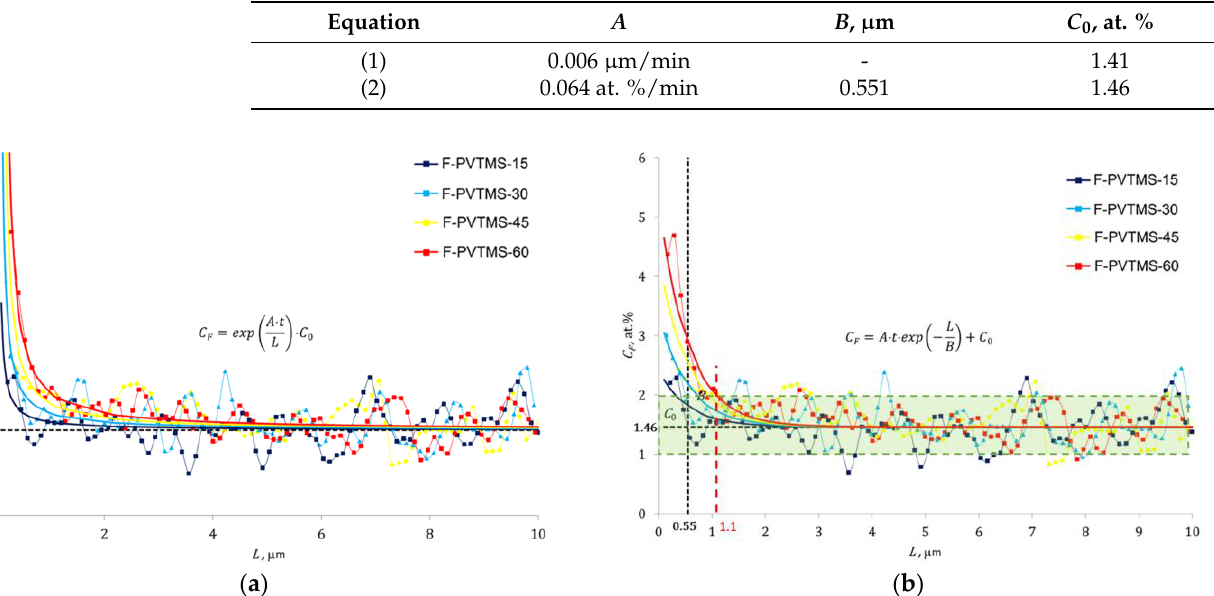
Table 1. Constant coefficients of Equations (1) and (2) for the studied films.